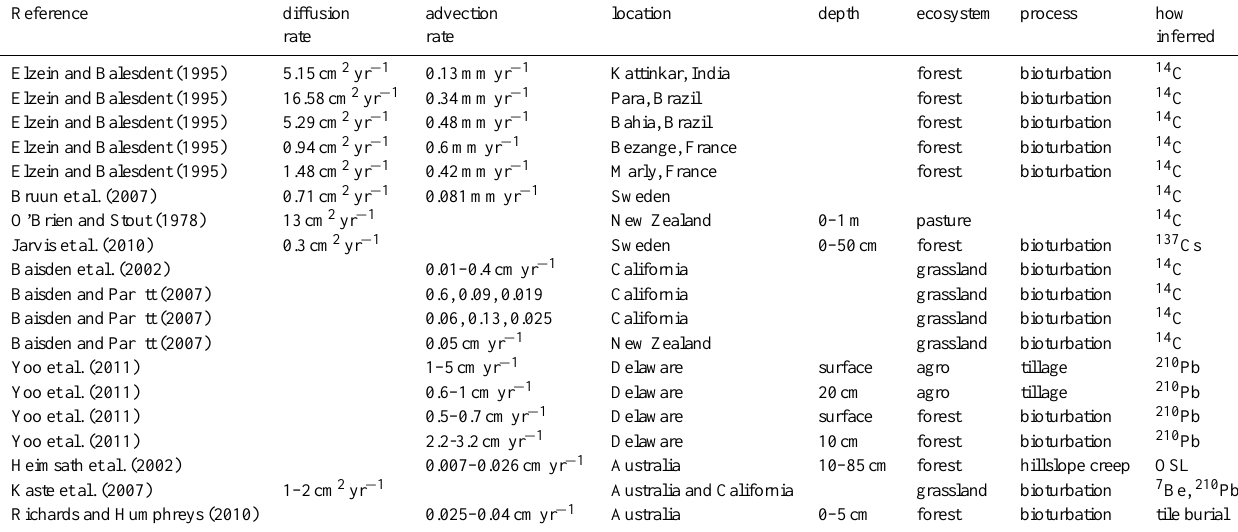
Table 3. The literature-reported values of SOM vertical mixing